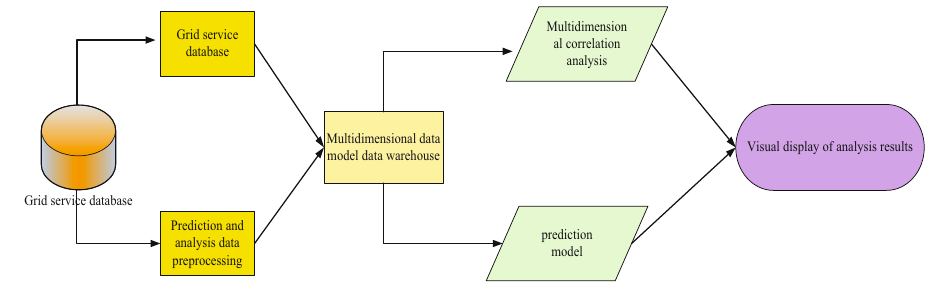
Figure 8: Grid data analysis